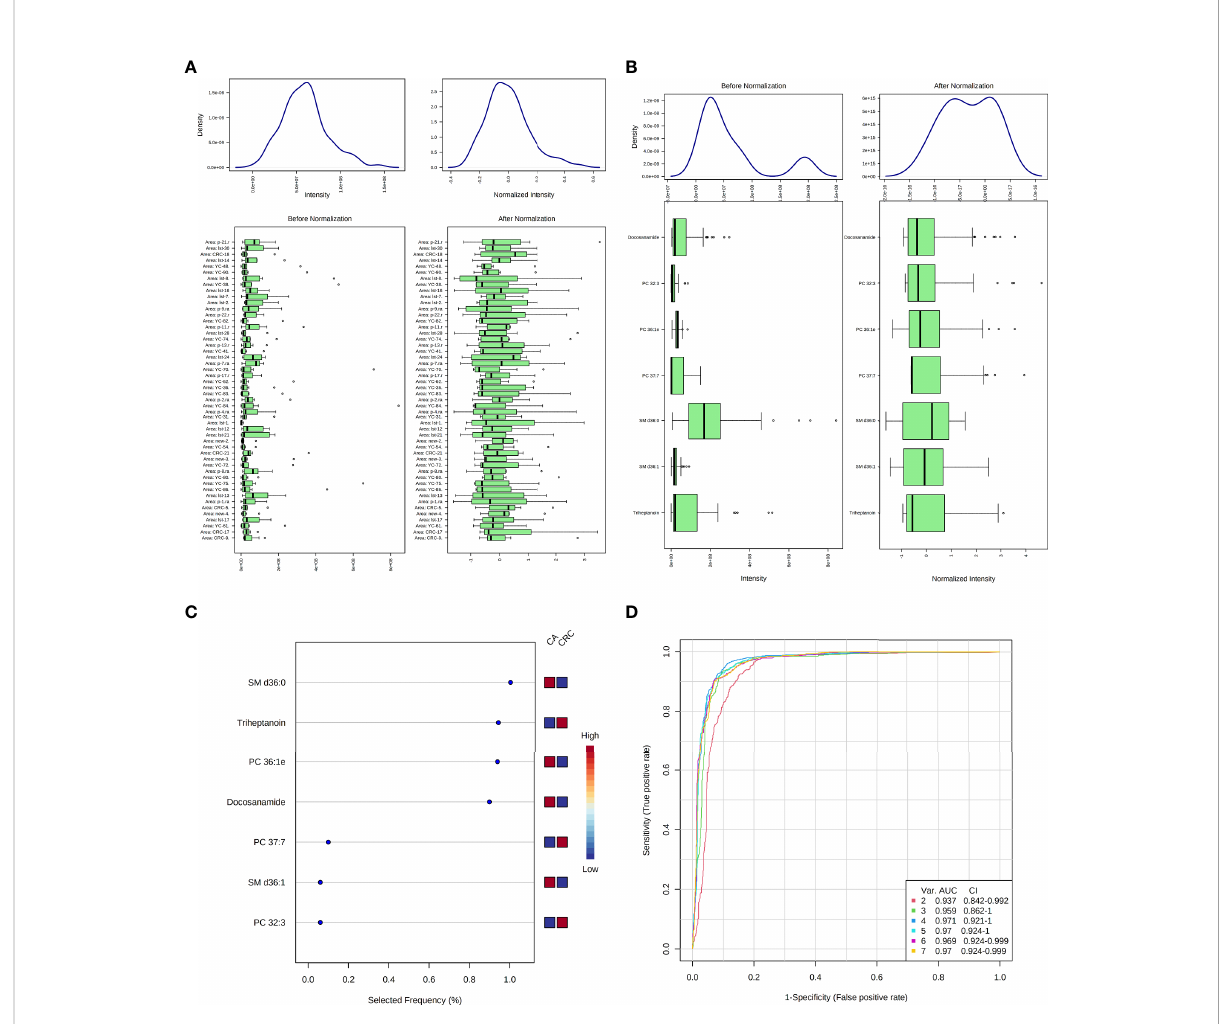
FIGURE 5 Data normalization and multivariate ROC analysis of differential lipid species between CA and CRC groups. Normalization of samples (A) ; normalization of differential lipid species between CA and CRC groups (B) ; the selected frequency of differential lipid species during multivariate ROC analysis by SVM algorithm (C) ; the multivariate ROC analysis of differential lipid species with high differentiate performance for CA and CRC groups (D)